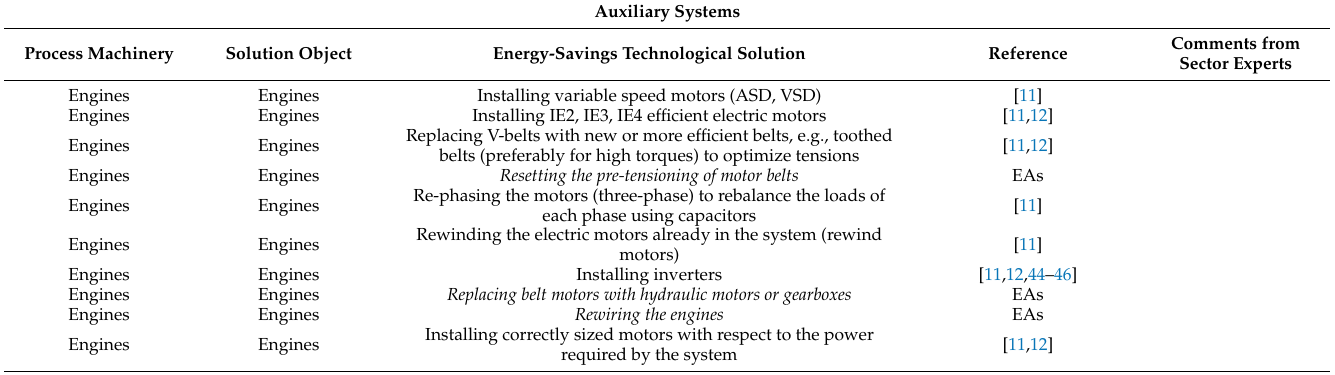
Table A5. Technology energy savings for auxiliary